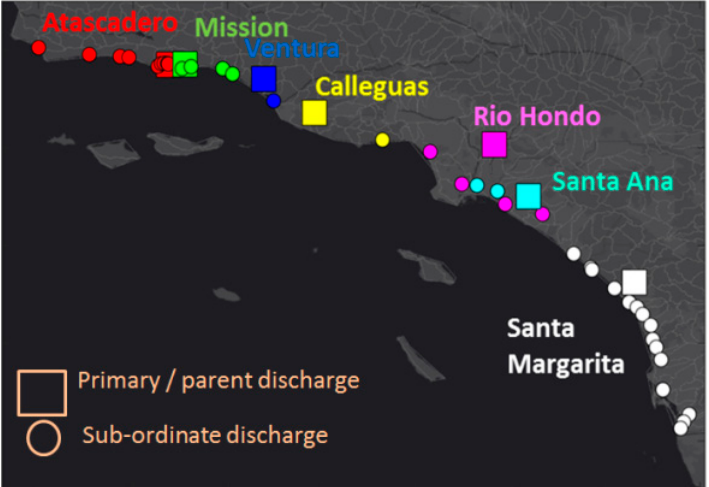
Figure 6. Locations and delineation of primary and sub-ordinate rivers and tributaries modeled in Southern California CoSMoS. Area-normalized runoff rates of primary (squares) discharge points were used to estimate discharge rates at sub-ordinate (circles of corresponding color) point locations. Table 3. Primary and sub-ordinate rivers within the Southern California study area.